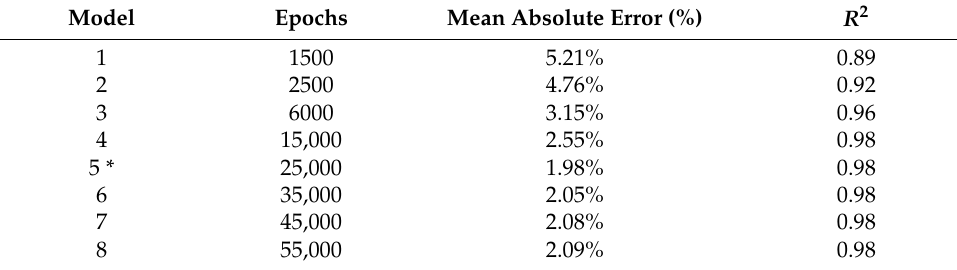
Table 7. Hyperparameter tuning for epochs.